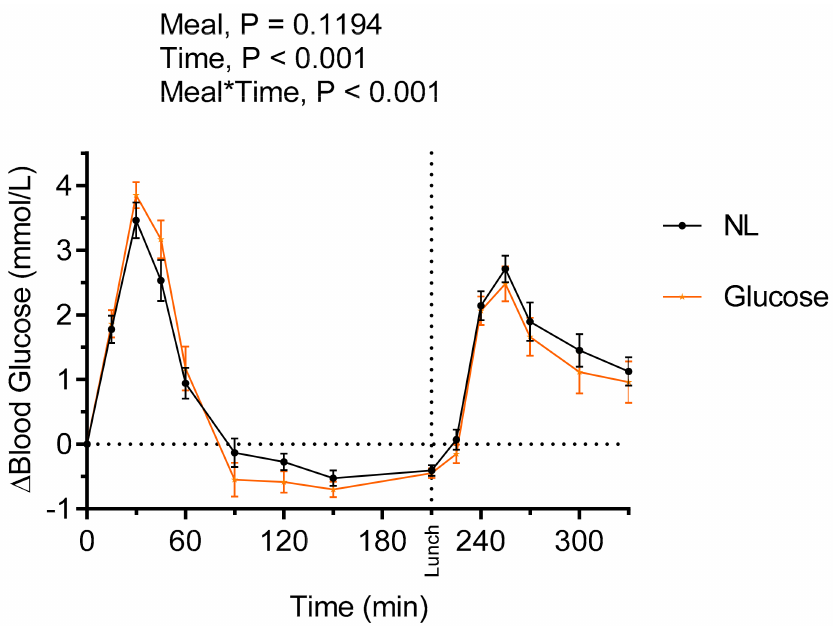
Figure 1. Incremental changes in serum blood glucose concentrations after test breakfasts and standardized lunch meals. Values are means ± SEM, n = 20 healthy subjects. Repeated measures; mixed model in SAS. NL, oat preparation without added oat polar lipids; glucose, glucose